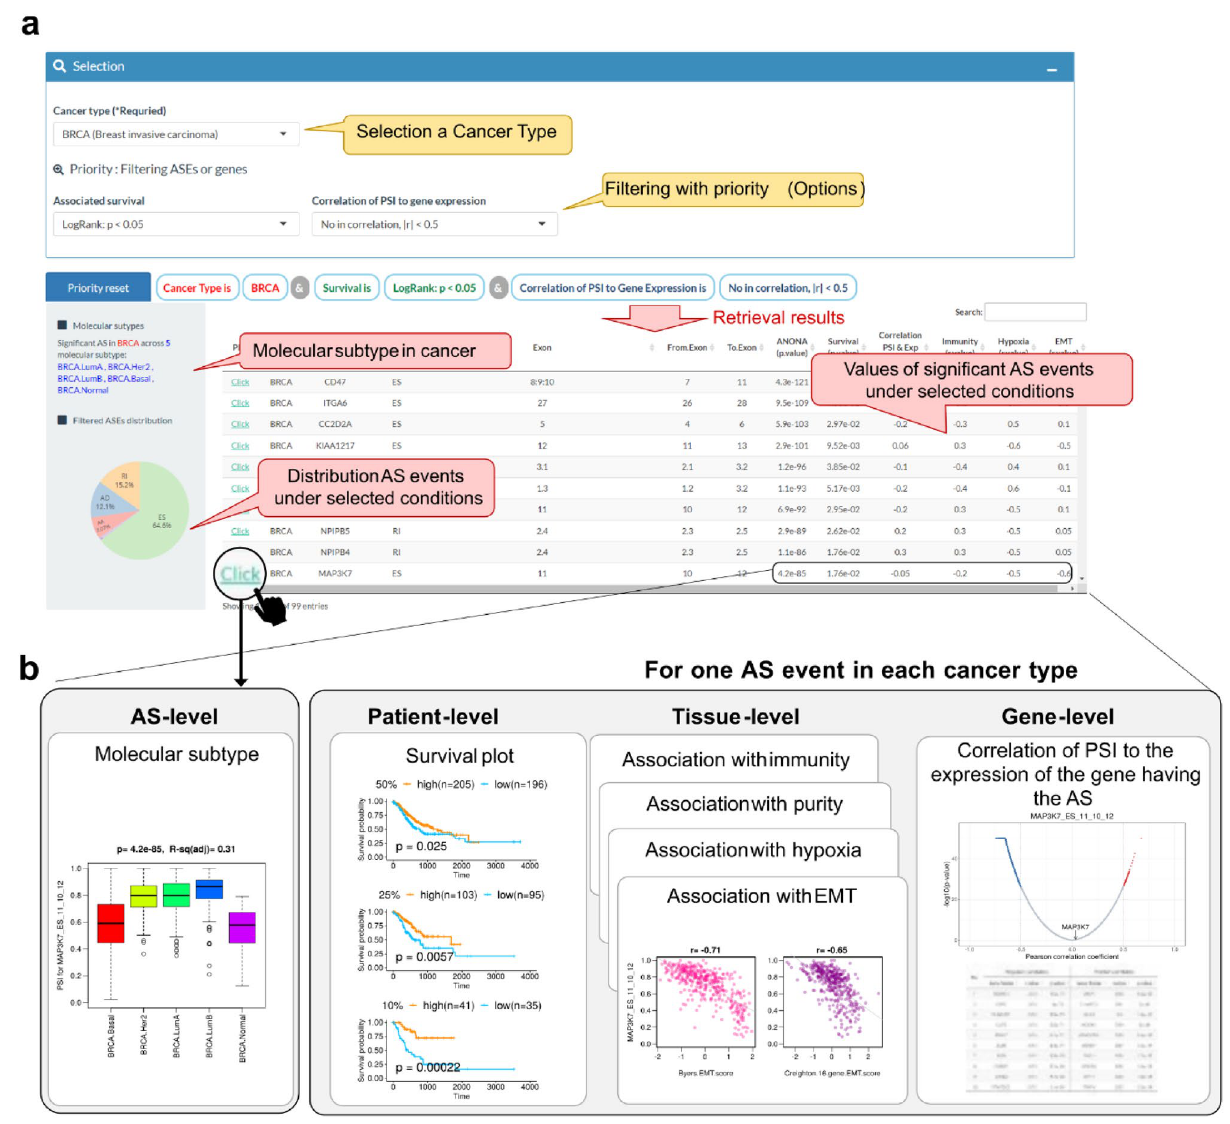
Figure 3. An example of “Single-cancer AS” part in AS-CMC. (a) List of subtype-specific AS events for a selected cancer type. Once a cancer type is selected, the subtype-specific AS events are shown with relevant statistics displayed in a tabular form. Users can filter the results using the defined cut-off in survival and correlation with the expression level of genes with the AS. (b) Visualization panel showing the analysis results of an AS event. Once an AS event is selected, a window with various plots pops